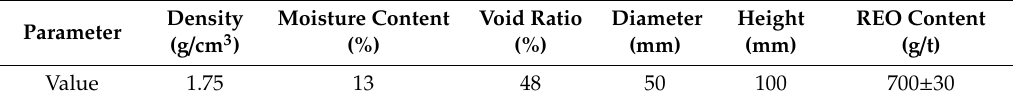
Table 3. Parameters of the remolded rare earth